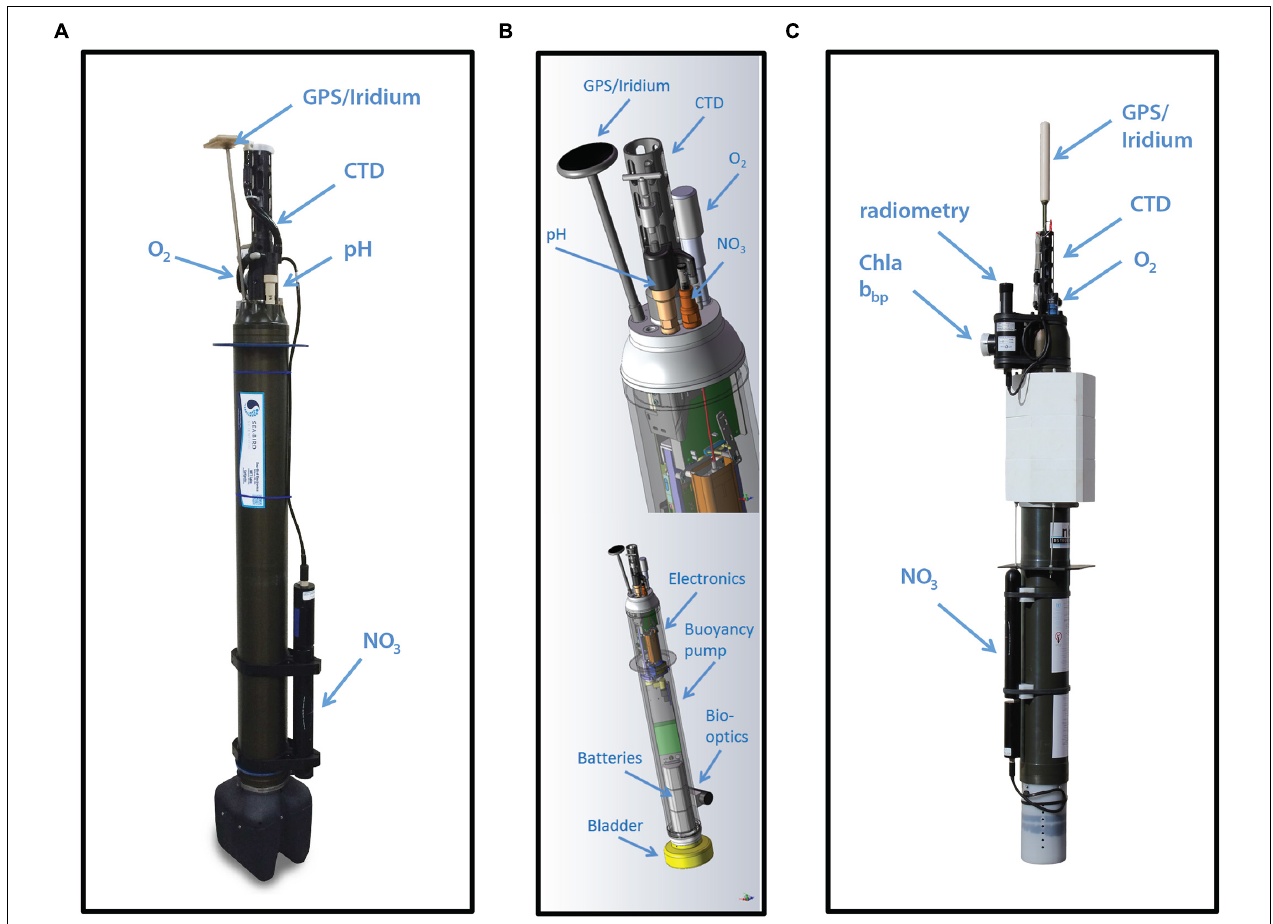
FIGURE 1 | The three main models of BGC-Argo floats presently in use include (A) Navis, (B) APEX, and (C)